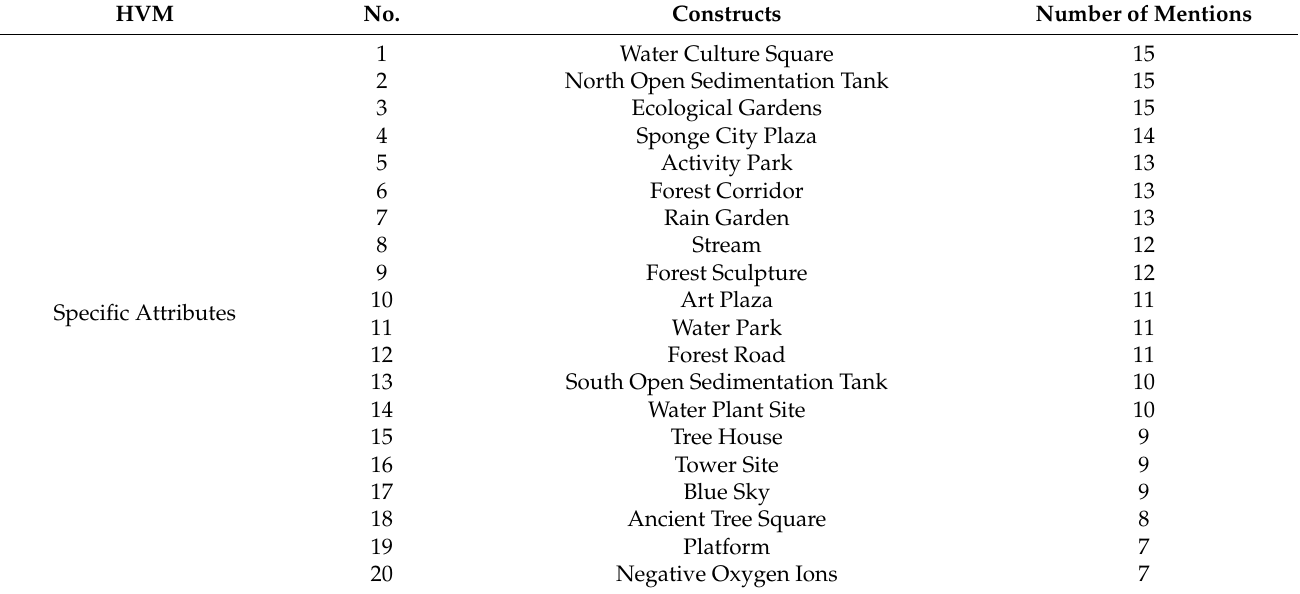
Table 4. Hierarchical value map (HVM) developed in our